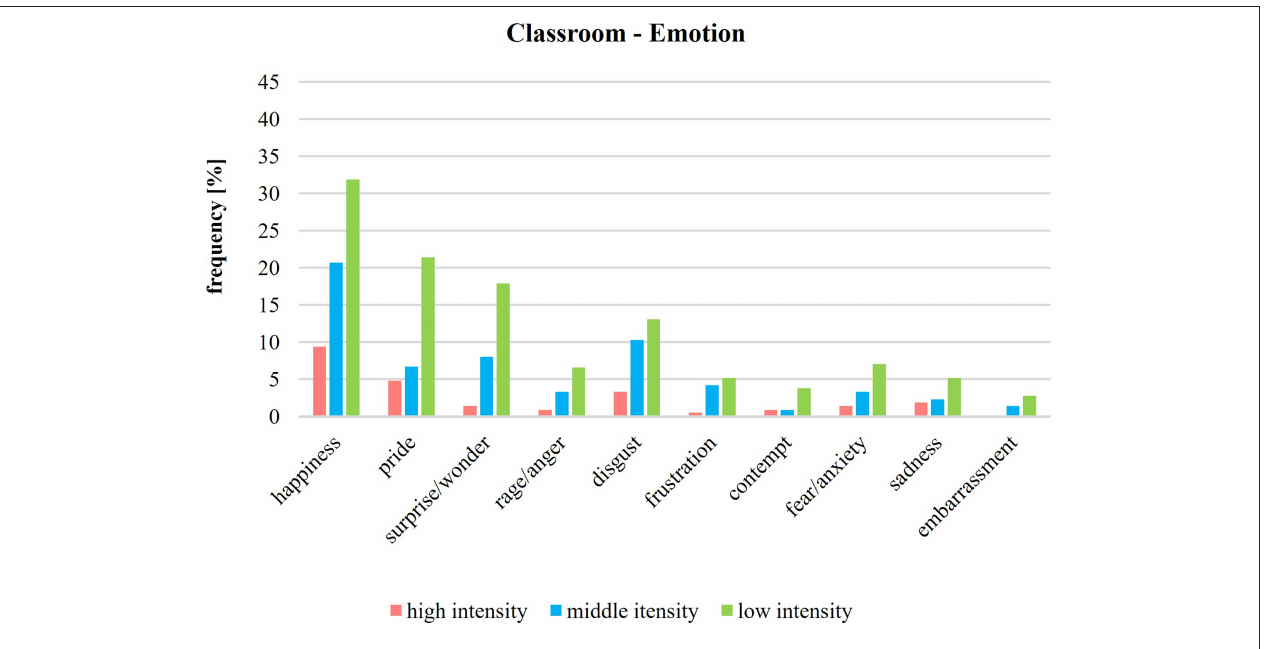
FIGURE 5 | Intensity of emotions during classroom lessons ( n =